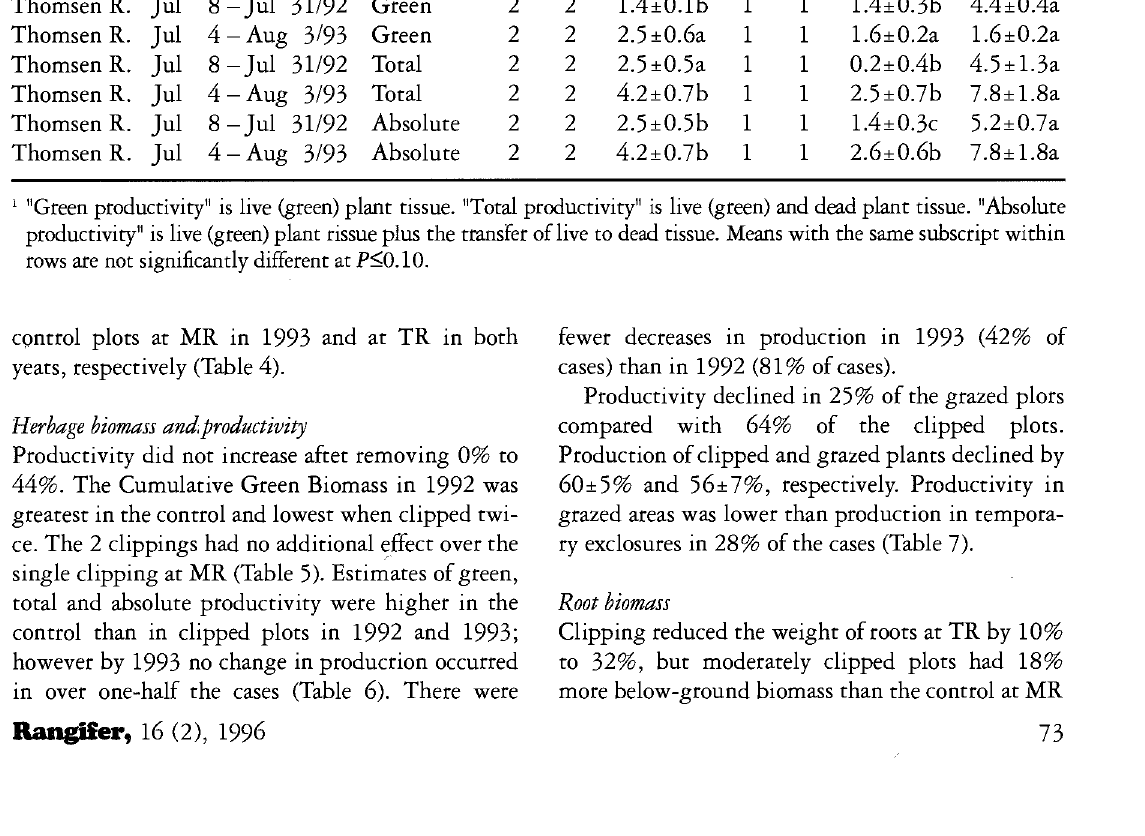
Table 6. Mean (±SE) green, total and absolute productivity estimates 1 (g m' 2 d" 1 ) among treatments in 1992 and 1993 lm x lm plots («=5) inside permanent